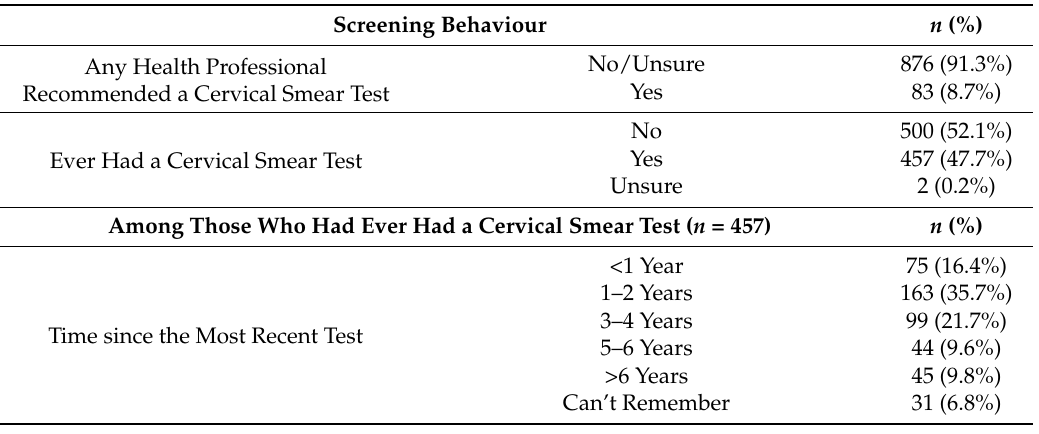
Table 3. Cervical cancer screening behaviour—cervical smear